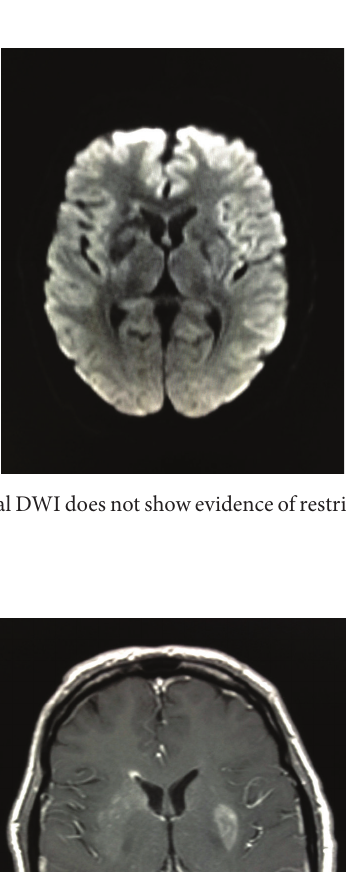
Figure 1: Axial Flair shows hyperintense signal in the right caudot- halamicgrooveneartherightforamenofMonroandintheleftputa- men.